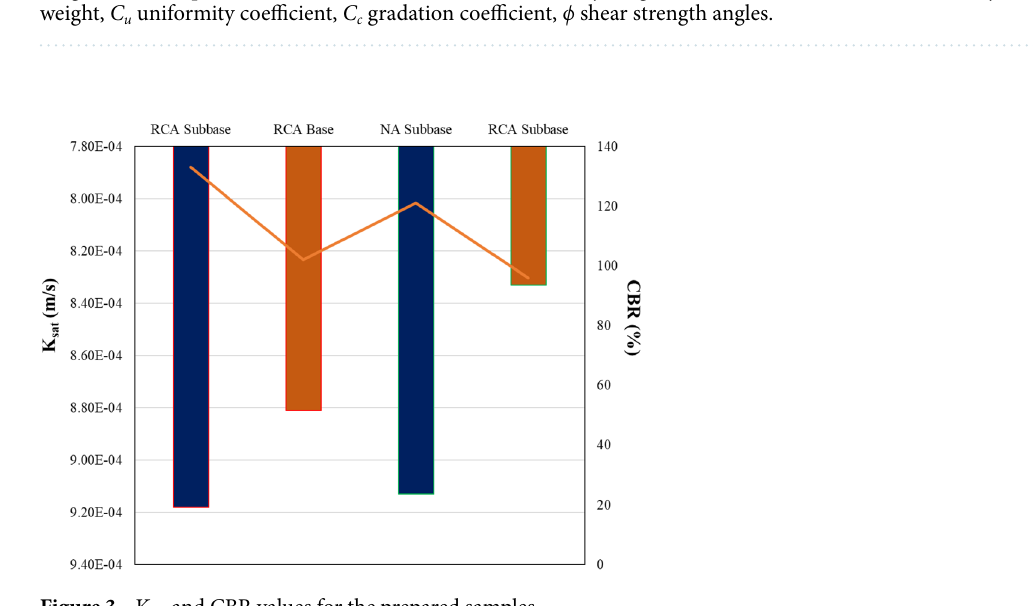
Figure 3. K sat and CBR values for the prepared